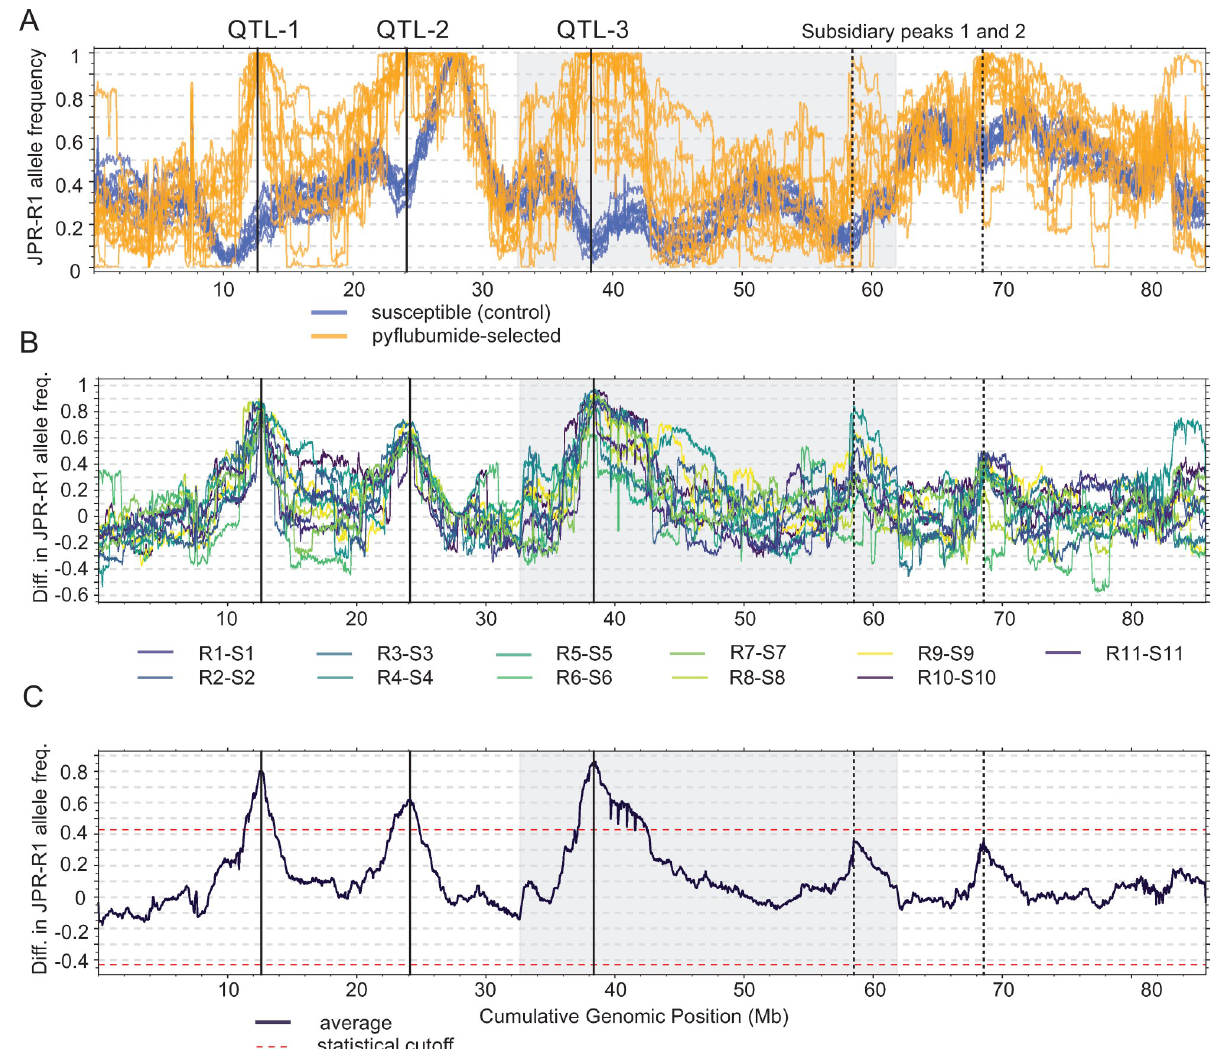
Fig 4. BSA genetic mapping reveals three QTL for pyflubumide resistance. (A) Frequency of JPR-R1 alleles in the susceptible control (blue lines) and pyflubumide-selected populations (orange lines) as assessed in a sliding window analysis. (B) Genome-wide differences in JPR-R1 allele frequencies between the eleven paired populations (R1-S1 to R11-S11), as assessed in a sliding window analysis. (C) Averaged genome-wide difference in JPR-R1 allele frequency using the eleven paired populations (R1-S1 to R11-S11). Dashed red lines delineate statistical significance for QTL detection as assessed by a permutation approach (FDR of 5%). In all panels, chromosomes are ordered by decreasing length and are indicated by alternating shading. Three QTL (QTL-1, QTL-2, and QTL-3) exceed the 5% FDR threshold; two sub-threshold peaks are also labeled (subsidiary peaks 1 and